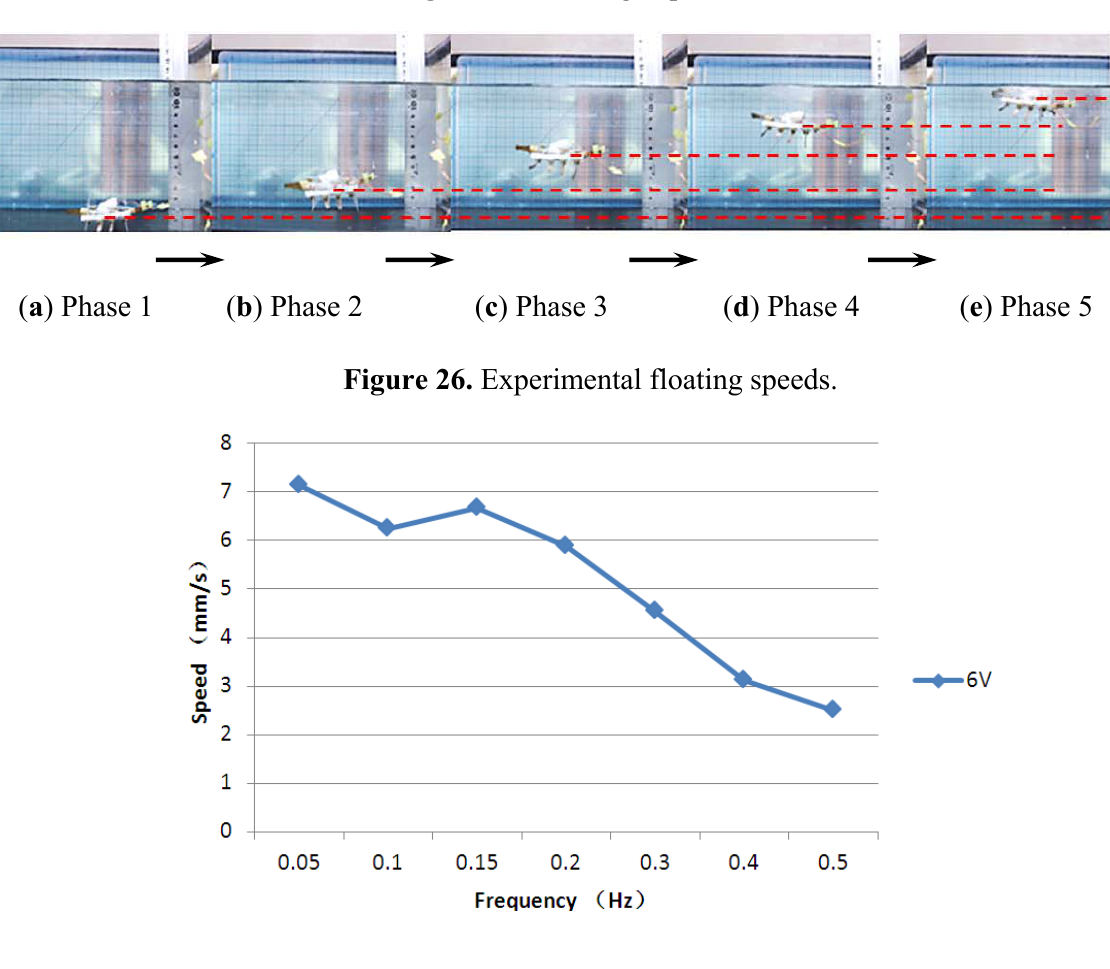
Figure 25. Floating experiment.